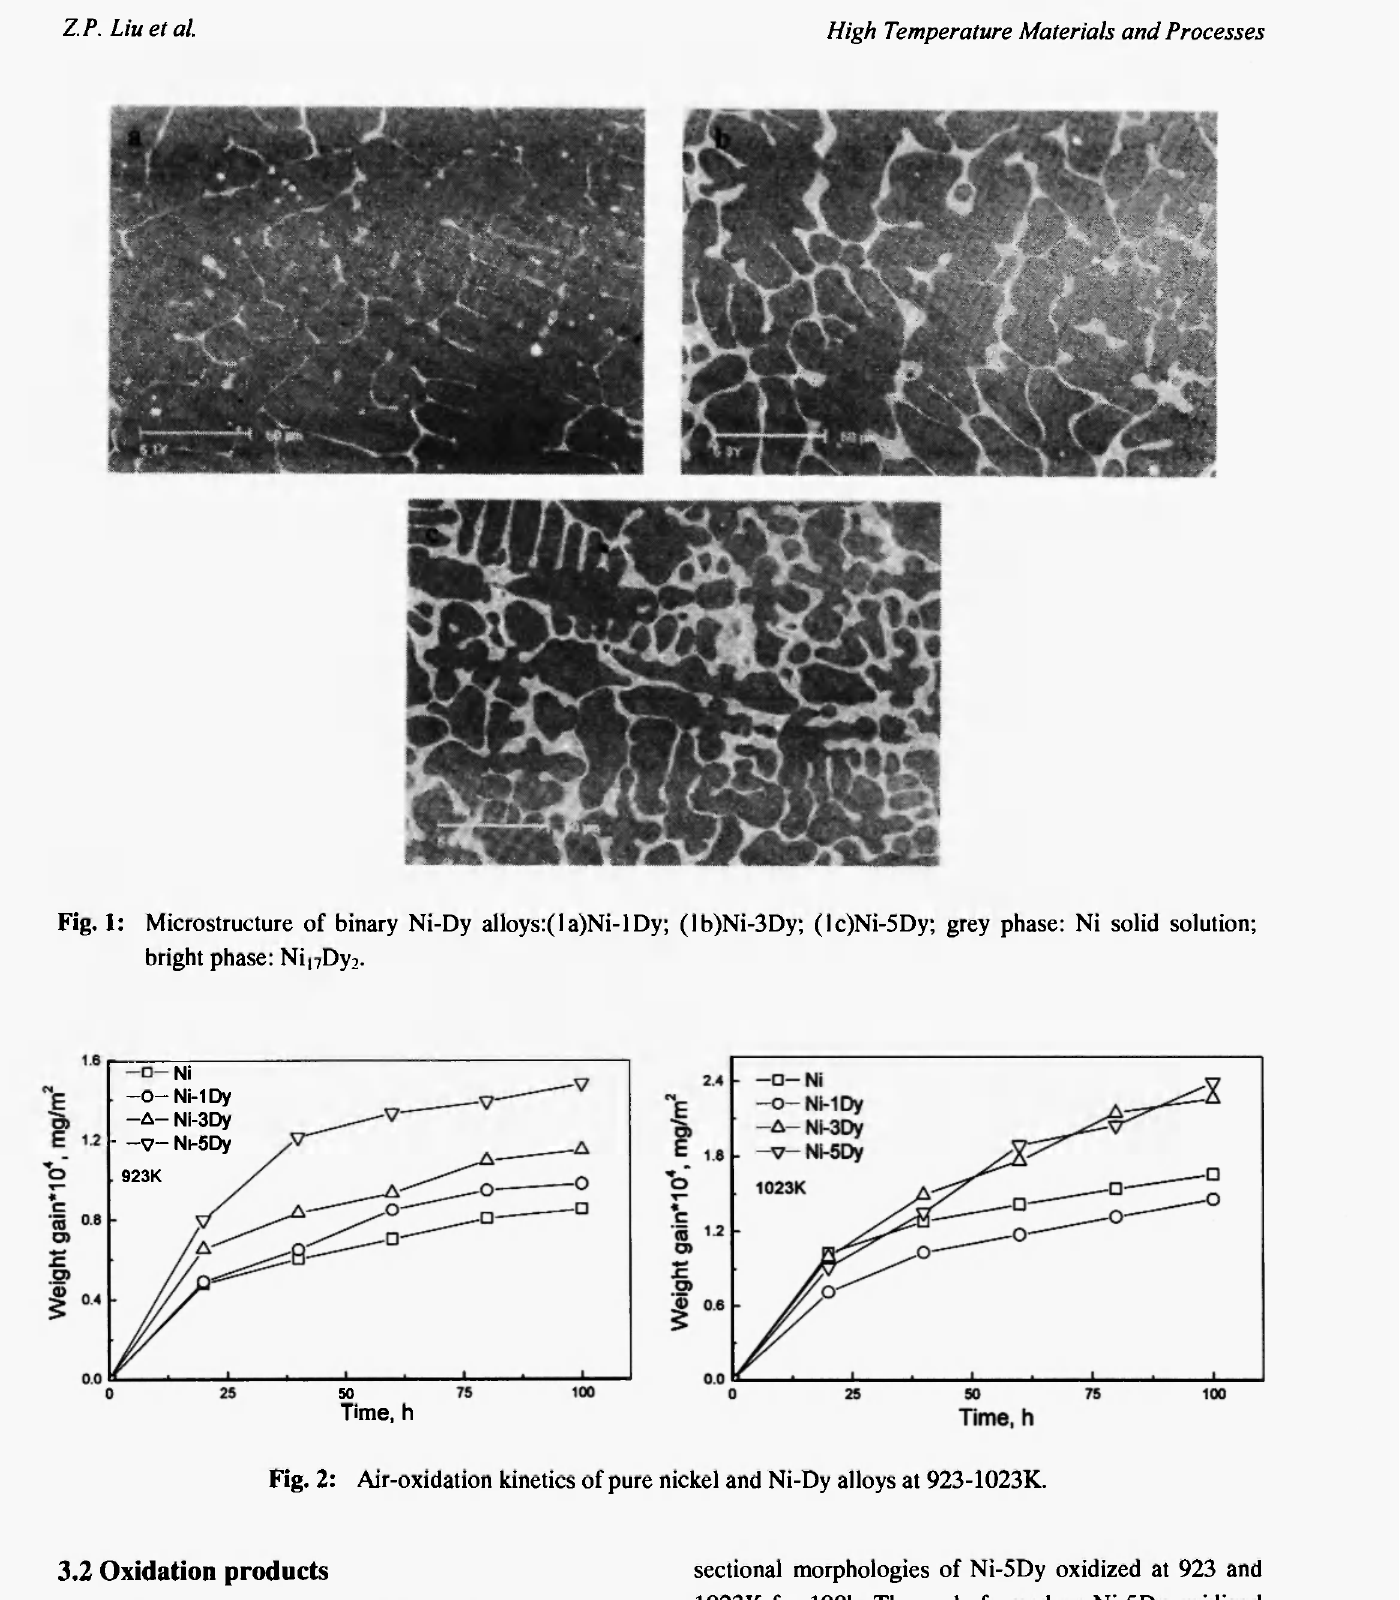
Fig. 2: Air-oxidation kinetics of pure nickel and Ni-Dy alloys at